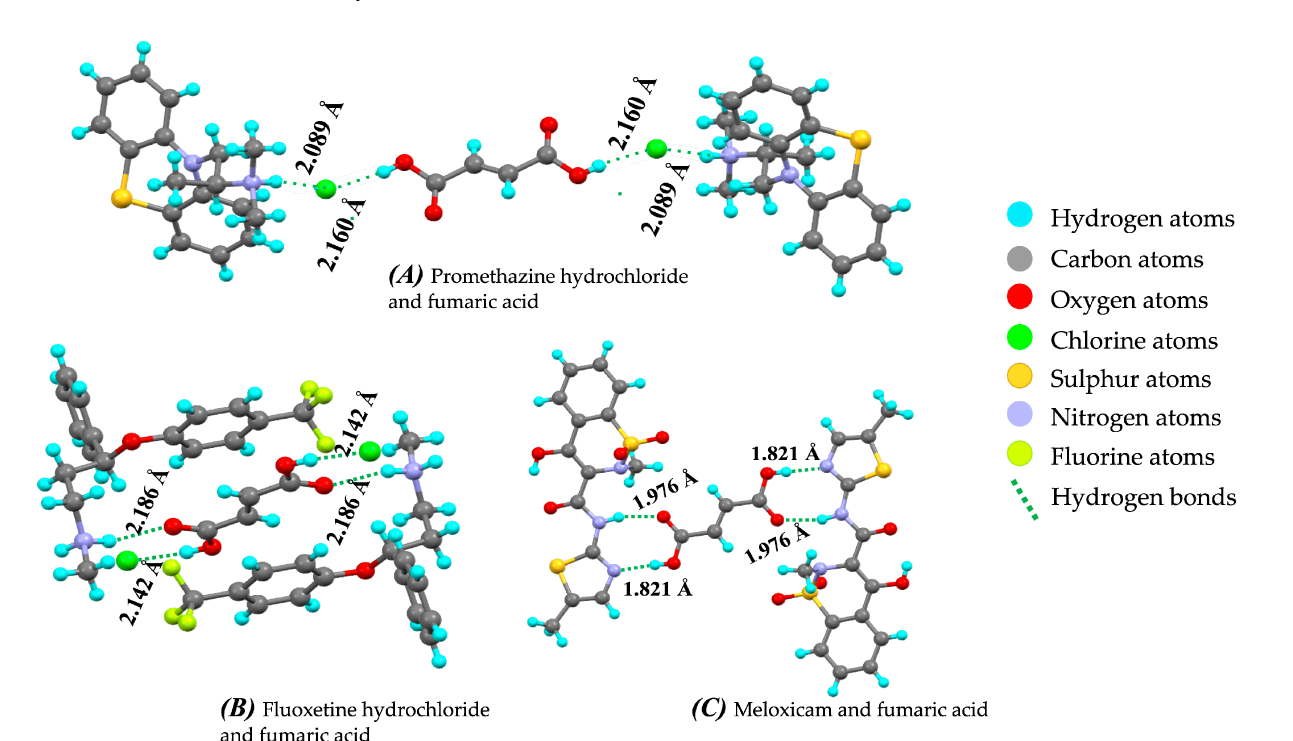
Figure 14. Hydrogen bond interaction and bond length between drug and coformer represented as ( A ) Promethazine hydrochloride and fumaric acid (#1853757), ( B ) Fluoxetine hydrochloride and fumaric acid (#254849), and ( C ) Meloxicam and fumaric acid (#819114) (from Mercury 2022.2.0 (Build 353591)). #—CCDC Identifier number. Table 8. Impact of fumaric acid as coformer on